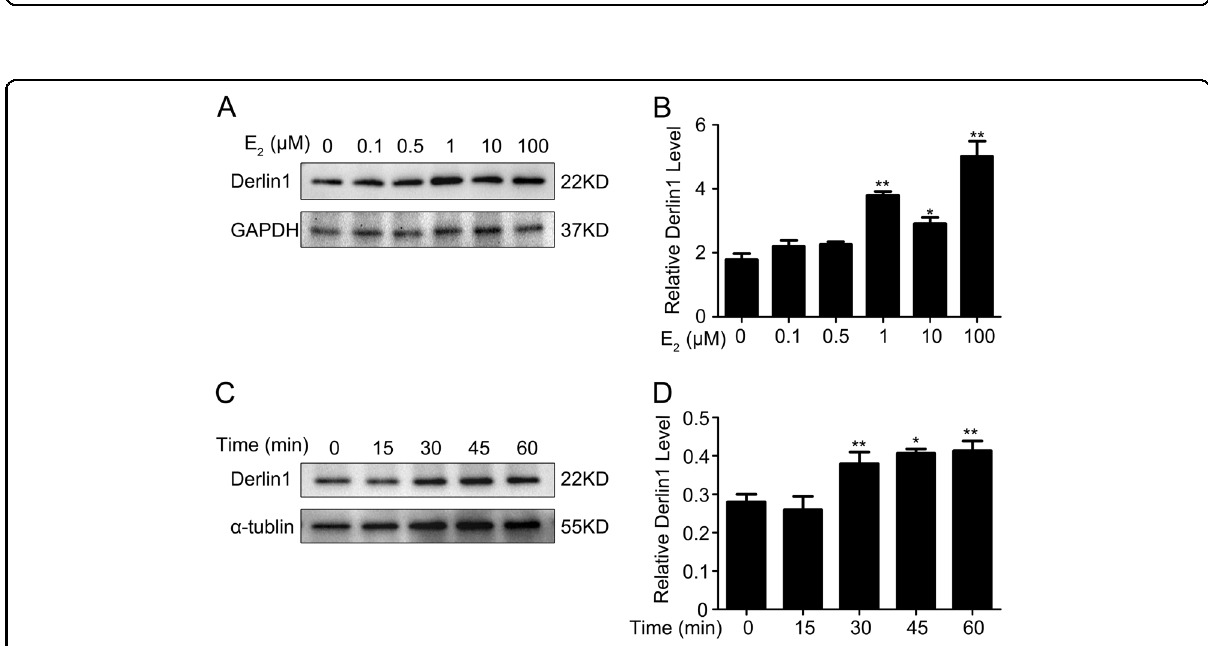
Fig. 5 Estrogen increases the expression of derlin-1 in mpkCCDc14 cells. a Endogenous derlin-1 expression was dose-dependently increased by E 2 treatment in mpkCCDc14 cells, as determined by western blot analysis. b Quantitation of the western blot data for derlin-1 protein shown in A normalized to GAPDH expression. The bars are the means ± SE from three independent experiments. * P < 0.05 and **P < 0.01 compared to the Con group. c E 2 induced the protein expression of derlin-1 in mpkCCDc14 cells during a time course, as determined by western blot analysis. d Quantitation of the time-course data for derlin-1 expression shown in ( c ) normalized to α -tubulin expression. The bars are the means ± SE values from three independent experiments. * P < 0.05 and **P < 0.01 compared to the Con